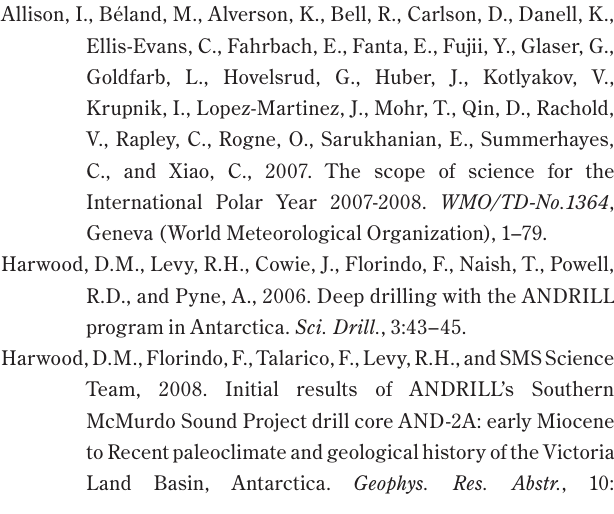
Fig. 1: Photo by Simon Nielsen Fig. 2: Satellite image courtesy of Steve Fischbein Fig. 4: Photo courtesy of ANDRILL Figs. 3 and 5: Photo by Lucia